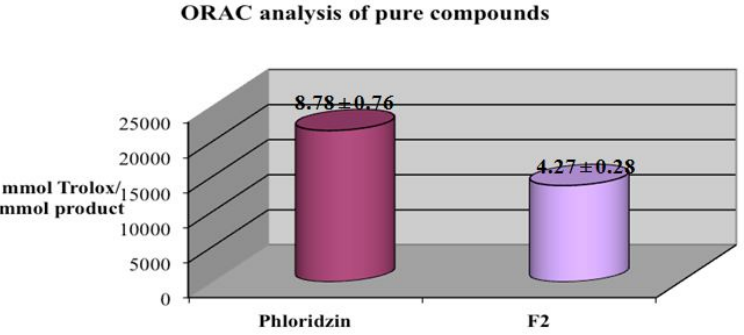
Figure 4. ORAC analysis of phloridzin and F2 . Each value was obtained from three experiments (Mean ±